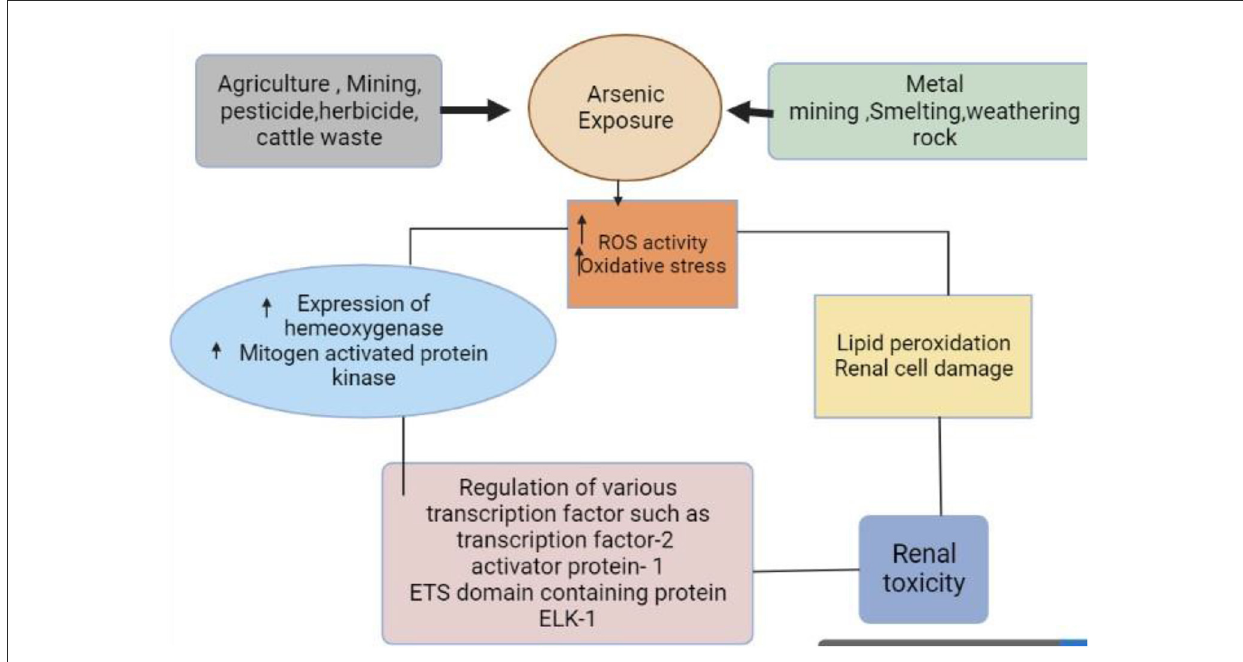
FIGURE3 Source and mechanism of arsenic exposure (derived from bio